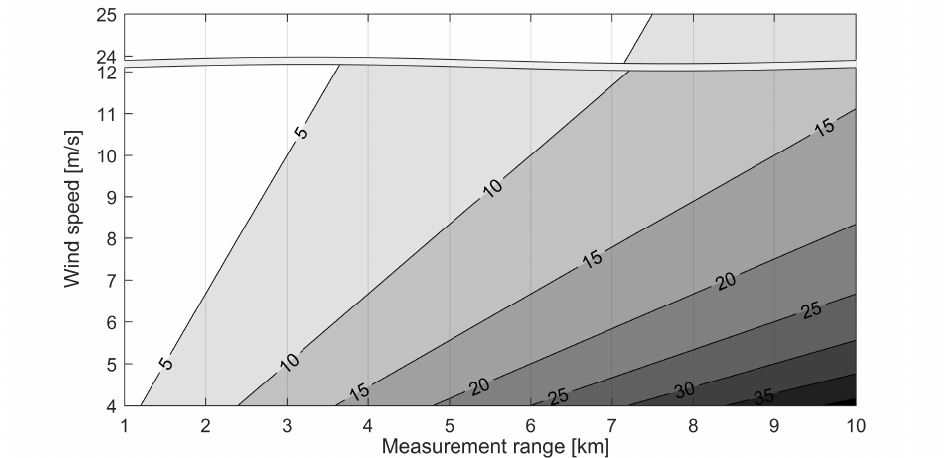
Figure 5. Forecast- horizon calculated based on Taylor for different wind speeds and measurement ranges; the horizon is given in